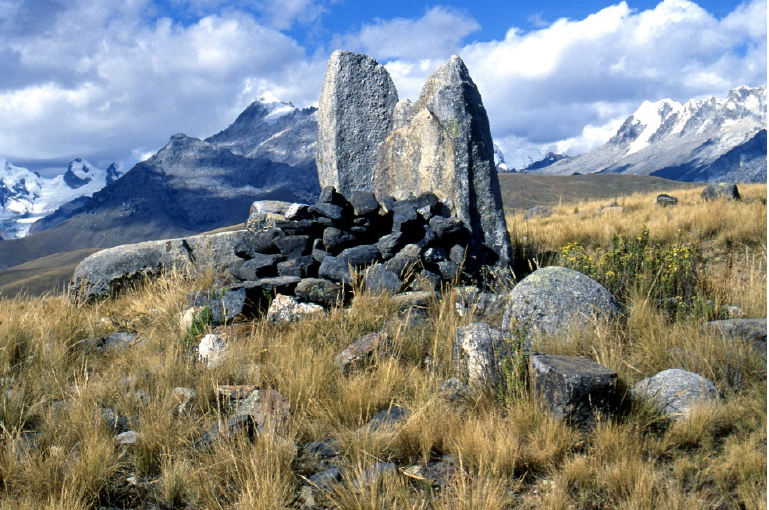
Figure 1. Standing stone uprights ( huancas ) at the foot of the Cordillera Blanca, above the city of Huaraz. Passersby have left stones to create an apacheta pile. Photograph by author.